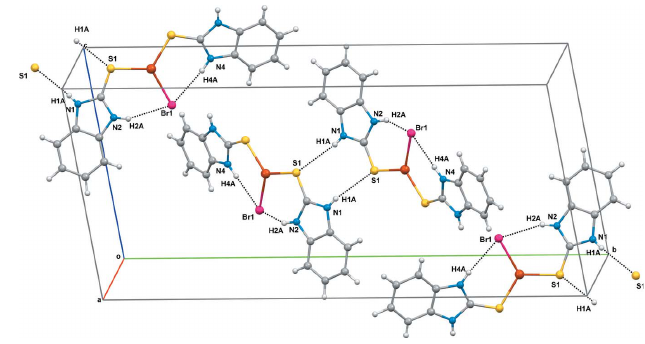
Figure 2 The intra- and inter molecular hydrogen-bonding interactions of ( 1